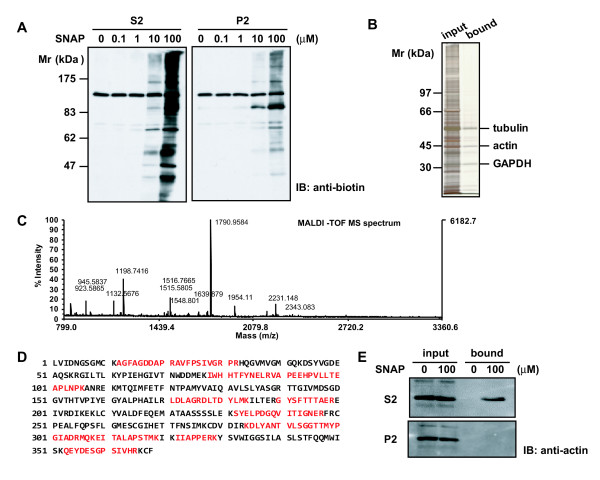
Identification of protein S-nitrosylated by SNAP in the spinal cord as actin. A. S2 and P2 fractions of mouse spinal cords were incubated with the indicated concentrations of SNAP for 1 h and subjected to the biotin-switch assay for S-nitrosylation of proteins. Samples (5 μg of each) were resolved by non-reducing SDS-PAGE and immunobloted with anti-biotin antibody. B. The S2 fraction was incubated with 100 μM SNAP for 1 h and subjected to the biotin-switch assay. The biotinylated proteins were purified by using a streptavidin-agarose gel, and the bound proteins were eluted by SDS-sample buffer containing 2-mercaptoethanol. Eluates were analyzed by SDS-PAGE, and proteins were visualized by silver staining. Three major bands were identified as β-tubulin, β- and γ-actin, and glyceraldehyde-3-phosphate dehydorogenase (GAPDH). C. MALDI-TOF MS spectrum used for identification of actin. Twelve matched mass peaks are indicated. D. Amino acid sequence of mouse γ-actin. The parts of the sequence in red correspond to the peptide fragments obtained by tryptic digestion. The amino acid sequence of β-actin completely matches residues 20-351 of γ-actin except that P at the 31st residue of γ-actin was replaced by S at the 12th residue of β-actin. E. S-Nitrosylation of actin by SNAP in the S2 fraction, but not in the P2 fraction, of the spinal cord. S2 and P2 fractions of spinal cords were incubated with 100 μM SNAP for 1 h and subjected to the biotin-switch assay. After removing free biotin-HPDP, S-nitrosylated proteins were purified on streptavidin-agarose gels. Eluates were immunoblotted with anti-actin antibody as described in "Methods."